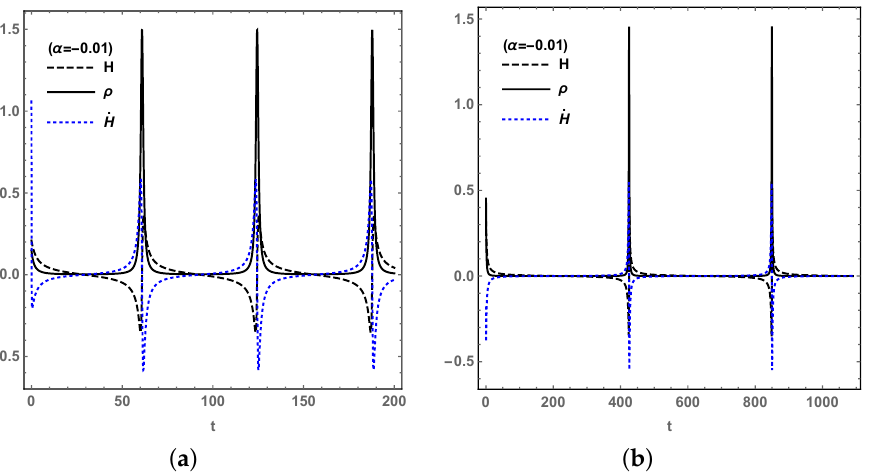
Figure 16. For P e 2 , the bouncing happens in LQC, with parameters η = 3, n = − 5, A = 0.002, B = 0.002 and coupling parameter α = − 0.01. ( a ) The initial values φ 0 = 0.6, ˙ φ 0 = 1.94, H 0 = 0.21 and ρ 0 = 0.15. ( b ) The initial values φ 0 = 0.5, ˙ φ 0 = 2.3, H 0 = 0.3333 and ρ 0 = 0.5.